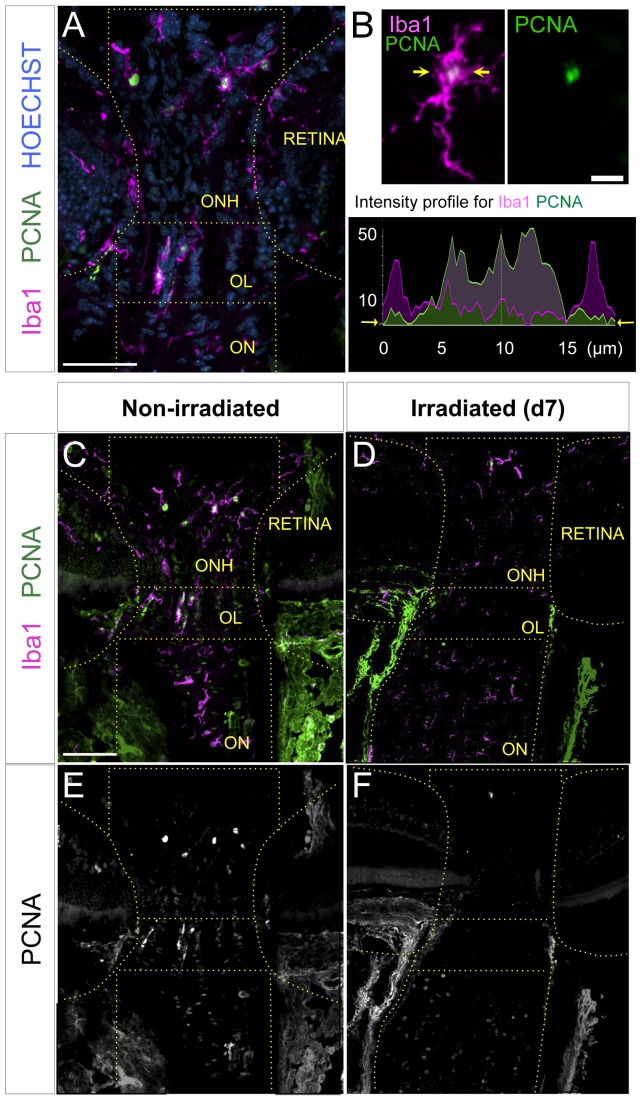
Irradiation results in depletion of proliferative microglia within the proximal optic nerve regions.
(A) Iba1-positive cells with and without nuclear expression of the proliferative marker (PCNA) were detected in radial sections along the ONH, OL and proximal ON (delineated) shown in a single 1 µm optical slice. (B) Overlay of Iba1 and PCNA, plus single-channel view for PCNA. Scale bar represents 10 µm. The colocalization of Iba1 and PCNA to individual cells was confirmed by tracing their linear intensity profiles in single optical slices (between the arrows). Cycling microglial cells were positively identified by the nuclear localization of PCNA expression within the cytoplasmic Iba1 expression (graph). (C, E) Non-irradiated D2 mice show concentration of proliferating microglia within the unmyelinated ONH and OL, shown in a maximal Z-projection. Cycling microglia have a green or white nucleus in the overlay view of Iba1 and PCNA stainings, which is shown as single PCNA-channel for clarity. (D, F) 7 days (d7) after irradiation microglia proliferation appears negligible along the proximal nerve, as shown in a maximal Z-projection. Scale bars, 100 µm.